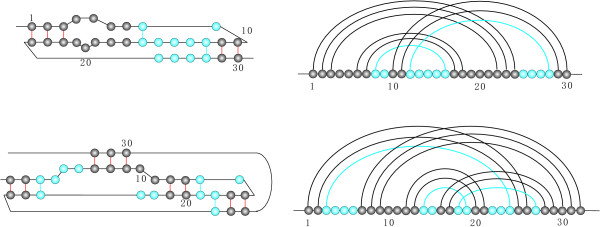
Pseudoknots. Pseudoknot loops, formed by all blue vertices and arcs.